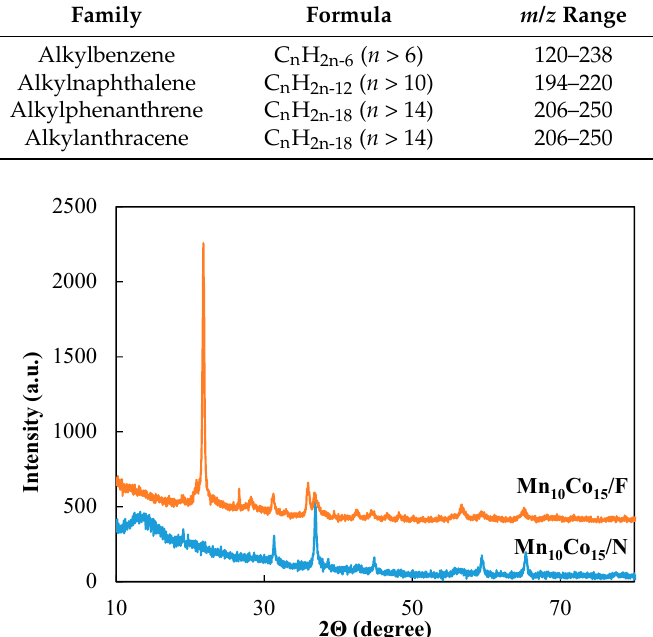
Figure 10. Diffractogram of the spent catalysts.